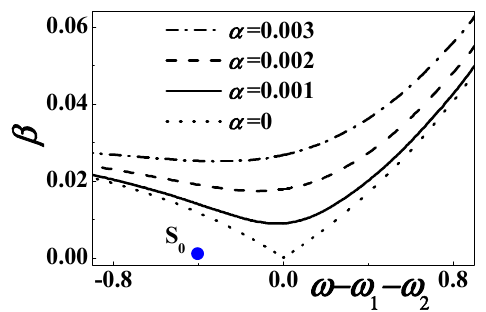
Figure 2. The stability boundary when ω ≈ ω 2 + ω 1.